Question: Briefly state, in one sentence, what is plotted here.
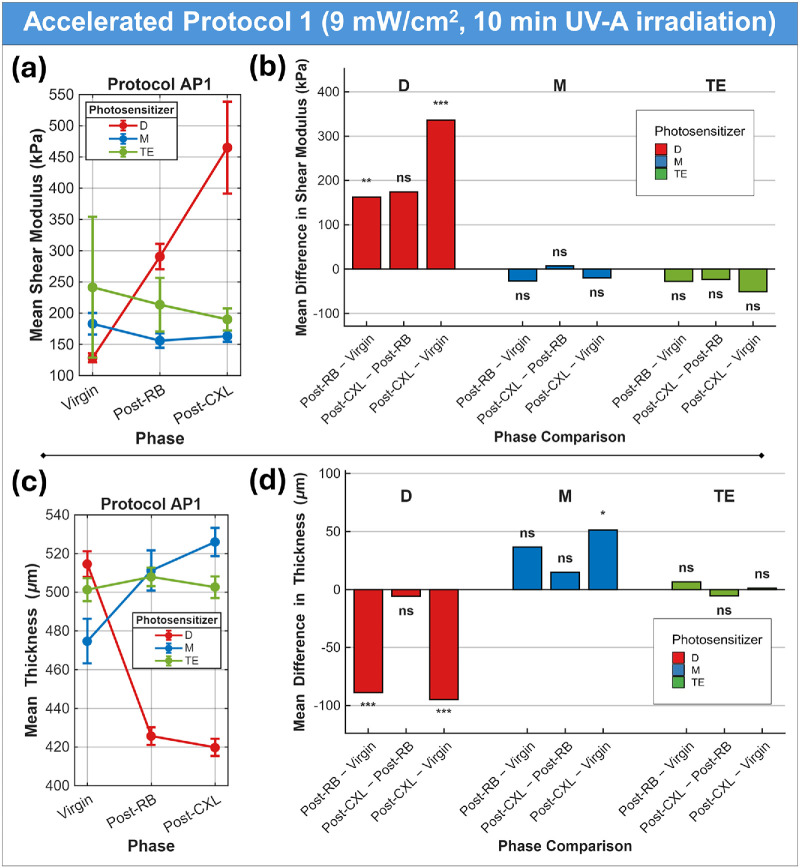
Answer: AP-1 statistical results. ( a ) Estimated average shear modulus with 95% confidence limits vs. treatment phase for all RB photosensitizers. ( b ) LME-predicted mean difference of shear modulus across phases: Virgin → Post-RB, Post-RB → Post-CXL, and Virgin → Post-CXL for all RB photosensitizers. ( c ) Estimated average corneal thickness with 95% confidence limits vs. treatment phase for all RB photosensitizers. ( d ) LME-predicted mean difference of corneal thickness across phases: Virgin → Post-RB, Post-RB → Post-CXL, and Virgin → Post-CXL for all RB photosensitizers. Significant differences are presented as *** P < 0.001; ** P < 0.01; and * P < 0.05. ns, not significant.